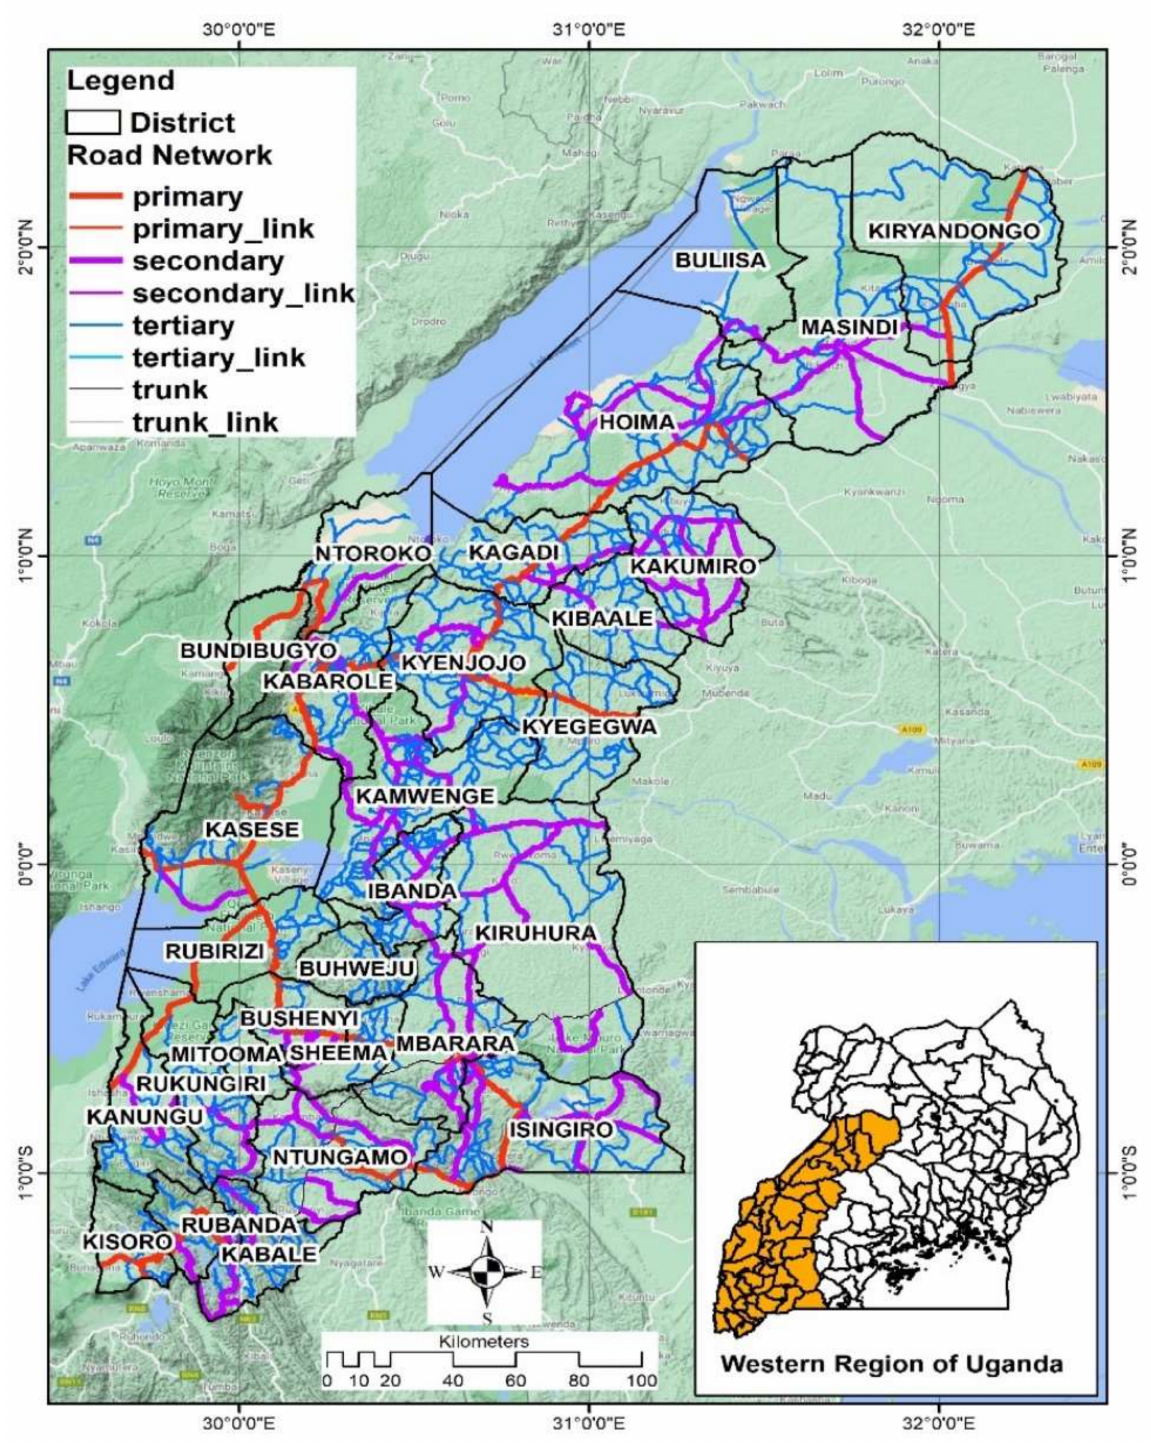
Figure 5. Road network map of study